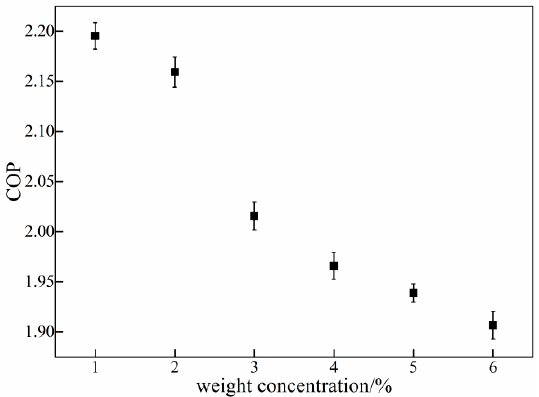
Figure 8. Effects of initial NaCl concentration on coefficient of performance (COP).